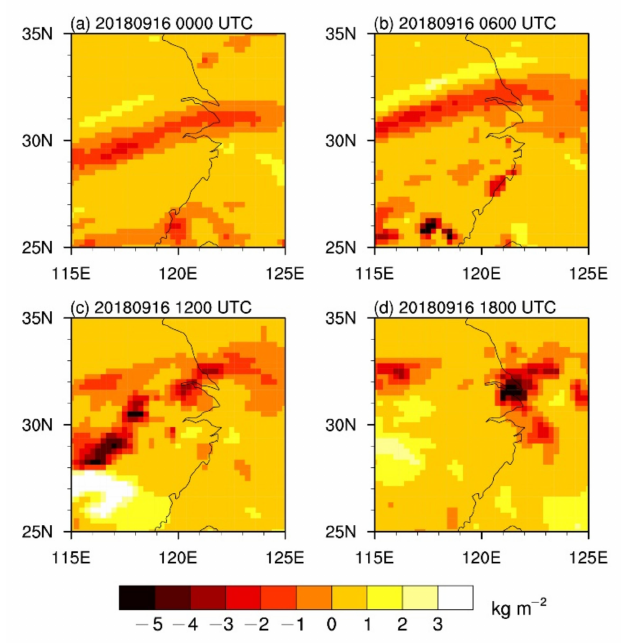
Figure 4. Vertically integrated moisture divergence from 0 to 18 UTC on 16 September 2018. ( a ) 0000